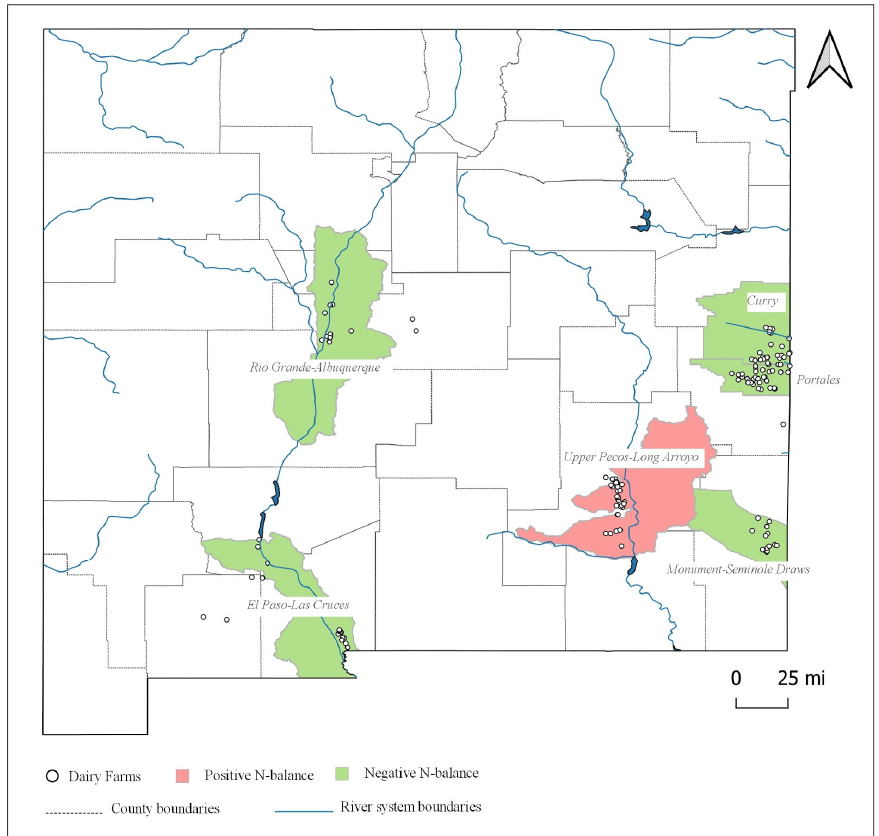
Figure 7. Nitrogen balance assessment at the watershed level.